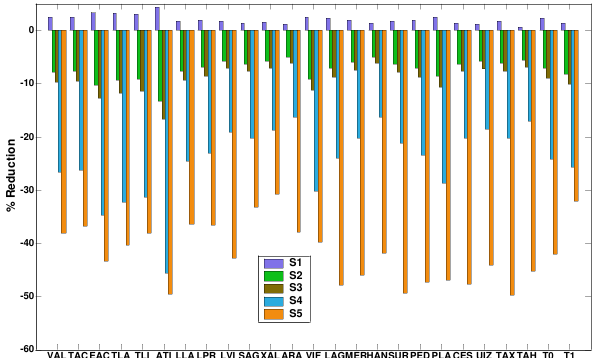
Figure 10. Influence of main external sources on the sulfur levels of the Mexico megacity under representative SO 2 emission reduc- tions scenarios. S1: Impact of NBR without changes in the MHR, FPRPP and MCMA urban emissions (purple); S2: Impact of NBR plus reductions in MHR as of 2012 (green); S3: NBR plus reduc- tions in MHR by 2017 (brown); S4: Impact of NBR plus reductions in MHR by 2017 and assuming a 70% of reduction in FPRPP emis- sions (blue); S5: Scenario S4 and assuming a 1/6th reduction of urban sources in the MCMA